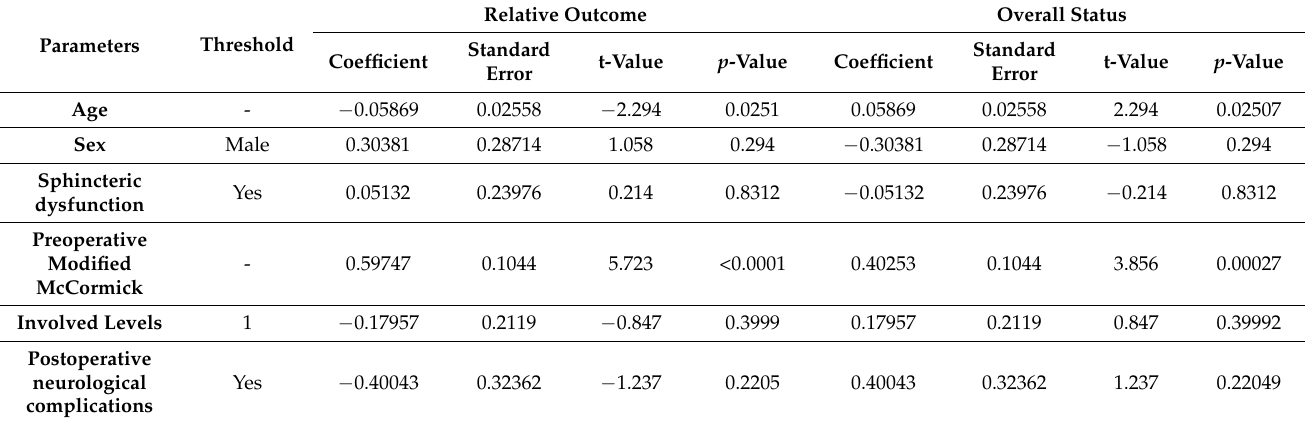
Table 4. Multivariate predictors of postoperative relative outcome improvement (represented by positive ∆ modified McCormick) and overall status (estimated with follow-up modified McCormick). Multivariate linear regression analysis ( n =